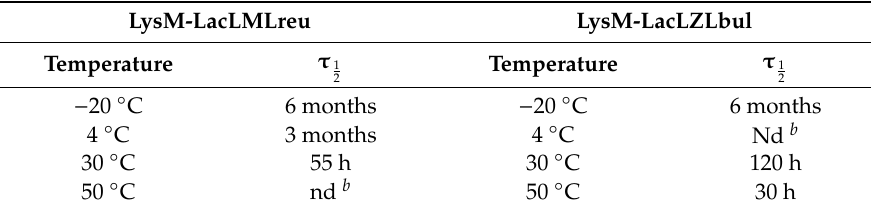
Table 3. Stability of L. plantarum β -galactosidase-displaying cells at various temperatures a . LysM-LacLMLreu LysM-LacLZLbul Temperature τ ½ Temperature τ ½